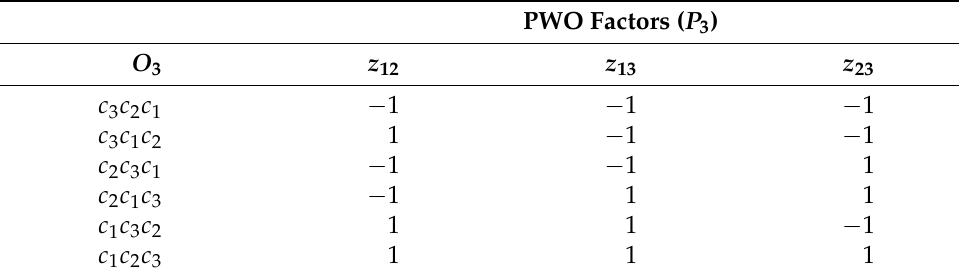
Table 1. Full OofA design O 3 and full PWO design P 3